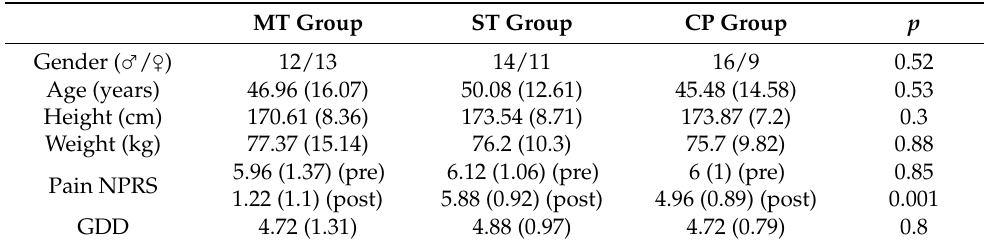
Table 1. Characteristics for all